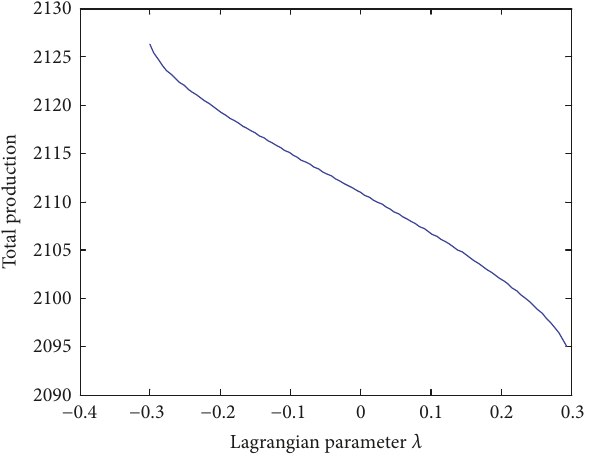
Figure 4: Total production under different 𝜆 .